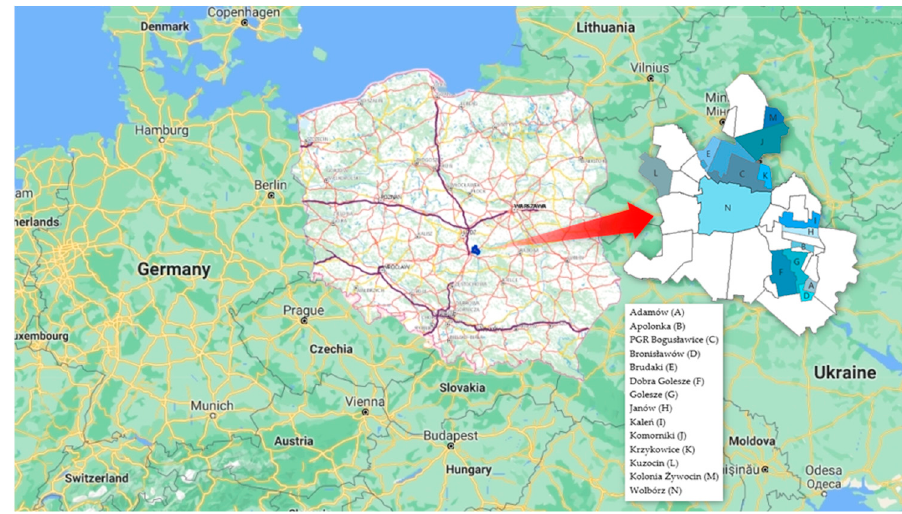
Figure 3. Study area. Source: own study [39 − 41].